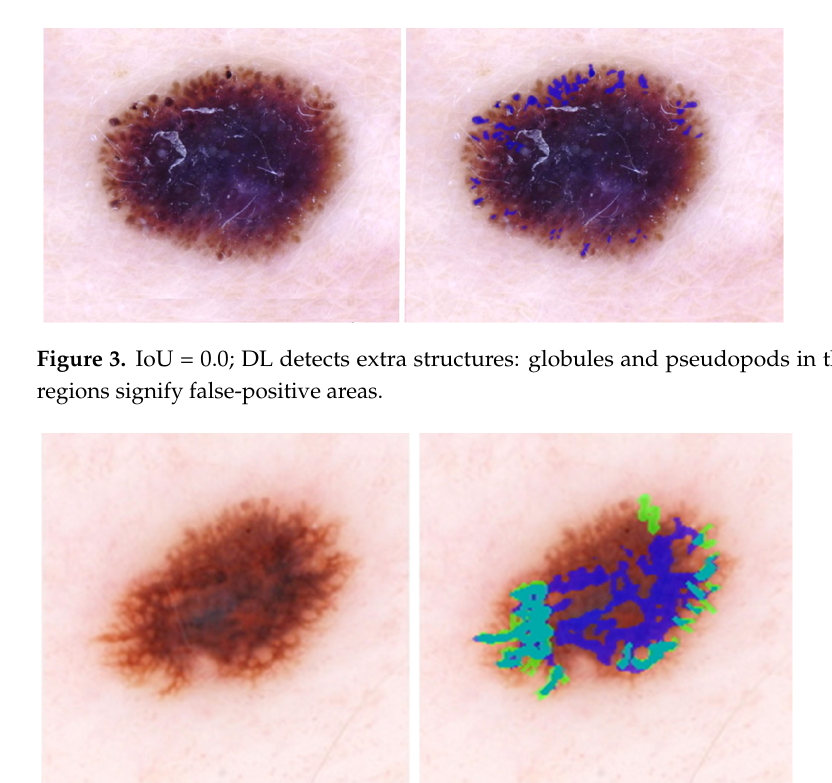
Figure 5. IoU = 0.78; DL can detect the areas of darkened lines and constricted holes in this mela- noma. The primary DL error is at the lower left, where DL detects normal network. 3.2. Classification For classification with our level-0 models, i.e., using conventional classifiers or DL models alone, we see that the DL models and their ensembles perform slightly better in terms of melanoma detection accuracy compared to the ensemble of conventional models when the probabilities are thresholded at 0.5. This is shown in Table 2 and can also be observed in the confusion matrices presented in Figure A2 and Figure A3 in Appendix A. We also observe that the ensembles of DL-only and conventional-only models show an improvement in accuracy over the individual classifiers of each type. After ensembling the DL models, we see an improvement of almost 4% in accuracy and recall over the best conventional-only model, the conventional classifier ensemble. This trend is also reflected in the ROC curves presented in Figure A1, where we have a high AUC of 0.917 for the DL ensemble compared to 0.881 for the conventional-only ensemble.